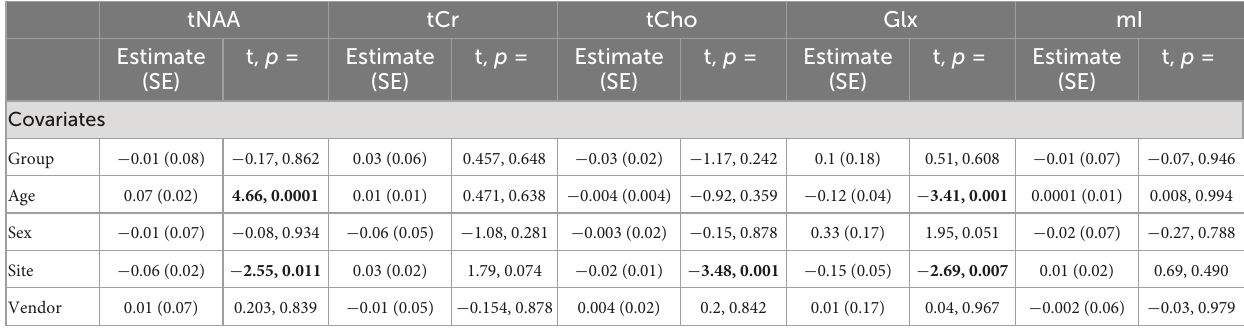
TABLE 7 Summary of the independent univariate general linear model (GLM) models for each metabolite (tNAA, tCr, tCho, Glx, and mI) harmonized by vendor to investigate group differences (concussion vs. OI).